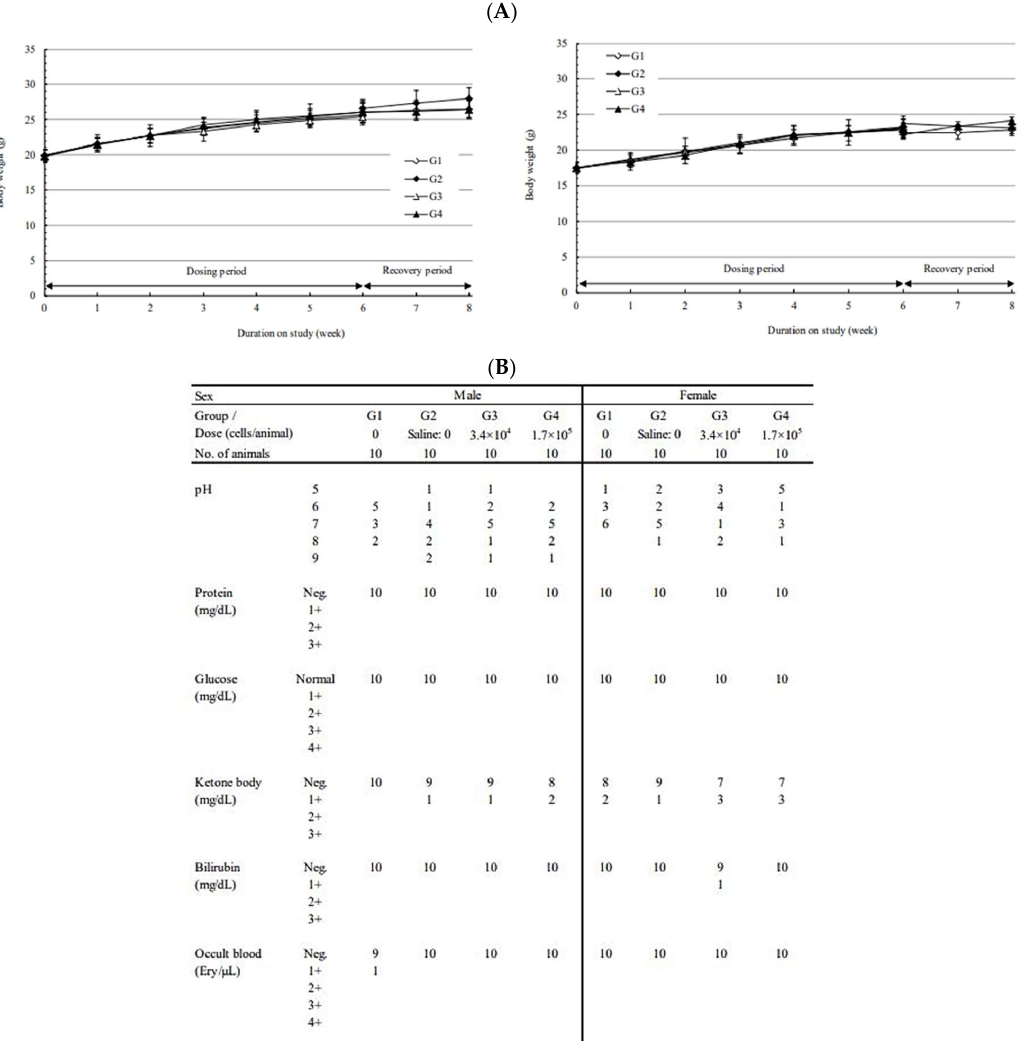
Figure 6. Subcutaneous dose toxicity study of CellgramDC in C57BL/6 mice. To test the safety and toxic response of the CellgramDC, female and male mice of C57BL/6 strain were subcutaneously injected with CellgramDC for a total of six weeks (one injection per week). The safety of Cell- gramDC was tested by subcutaneous injection into female and male mice for a total of six weeks (one injection per week). Administration groups consisted of two groups: 10 mice injected with 3.4 × 10 4 cells/animal and 15 mice injected with 1.7 × 10 5 cells/animal. A negative control group was comprised of 15 mice and were injected intravenously with a solution composed of excipient, plasma solution-A/human serum albumin (HSA) 90% + DMSO 10% and saline for six weeks (one injection per week). In order to test for a reversible toxic response, five mice from each comparison group, negative control group, and 1.7 × 10 5 cells/animal administration group, were given two weeks of the recovery period. During the recovery period, weight check ( A ), urinalysis ( B ), general symptoms, feed intake measurement, and ophthalmological examination were observed. Following the observation period, hematological tests, blood biochemical tests, and organ weight measurements were performed, as well as visual and histopathological examinations at